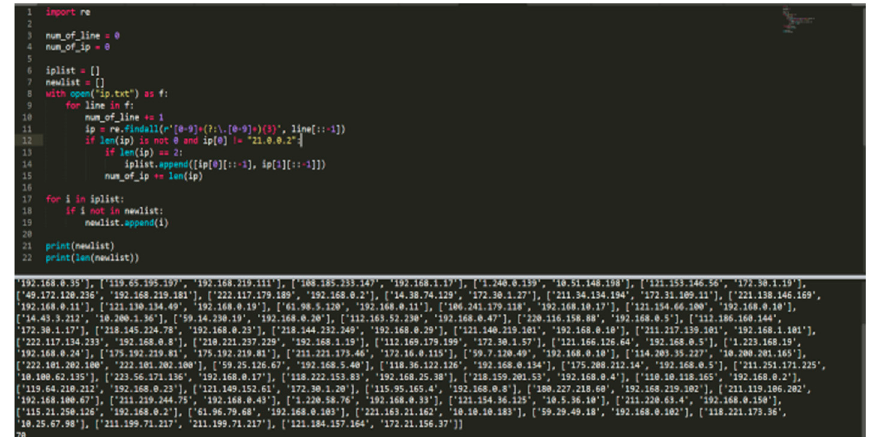
Figure A6. Verification script execution result.